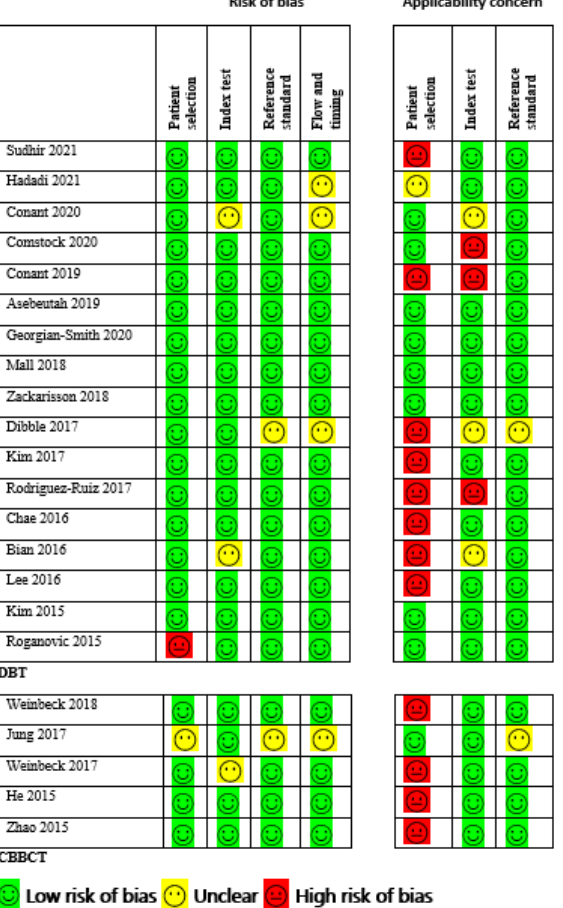
Figure 2. Risk of bias and applicability concerns: reviewers’ judgments about each domain for each included study. included